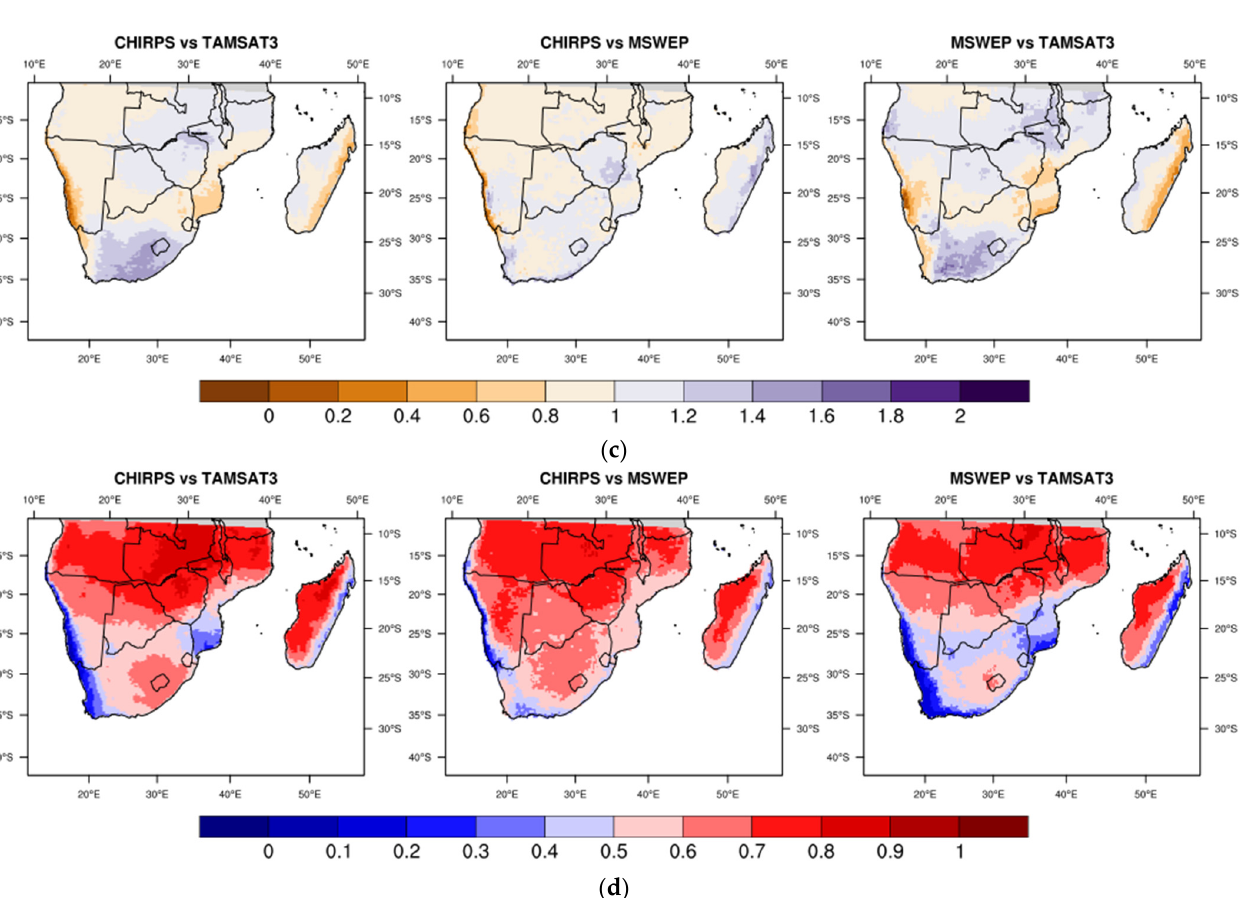
Figure 12. Maps of POD ( a ), FAR ( b ), BIAS ( c ) and HK ( d ) for SA. Table 4. Same as in Table 3 but for SA. POD FAR